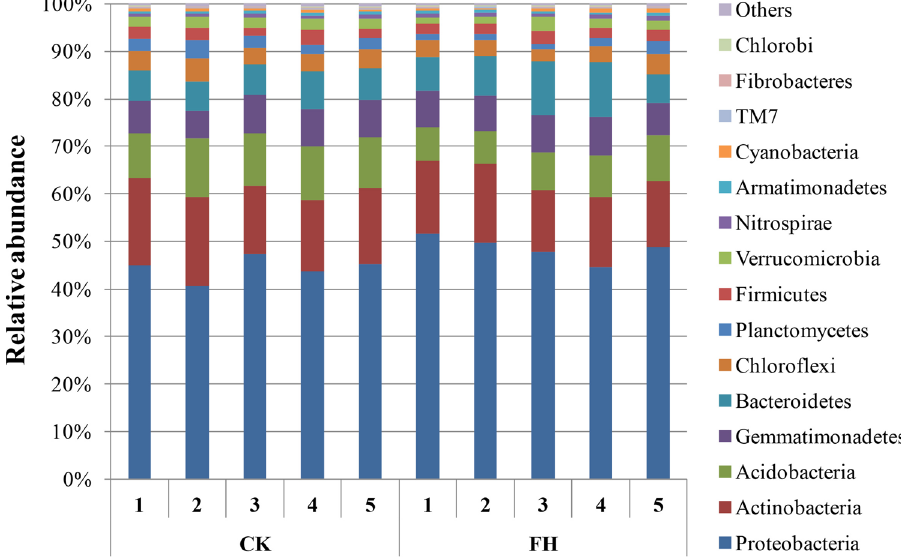
Figure 1. Relative abundance of the dominant rhizosphere bacterial phyla (proteobacterial classes) under different treatments. CK non-inoculated, FH inoculated with Bacillus amyloliquefaciens FH-1.